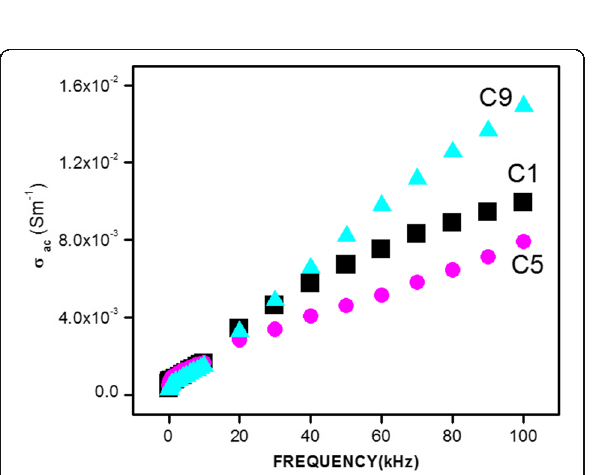
Fig. 9 Frequency vs AC conductivity for C1( x =0.1, y =0.45), C5( x =0.5, y =0.25), C9( x =0.9, y =0.05) at room